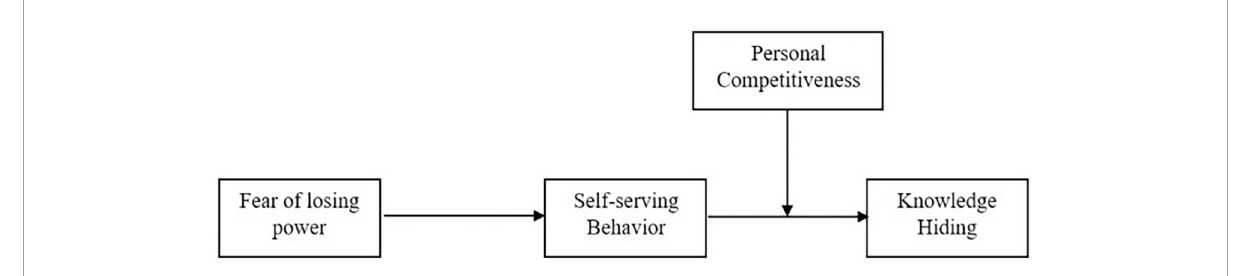
FIGURE1 Theoretical framework. Independent variable, Fear of losing power; dependent variable, knowledge hiding; mediator, self-serving behavior; moderator, personal competitiveness, solid lines representing hypothesized relationships.